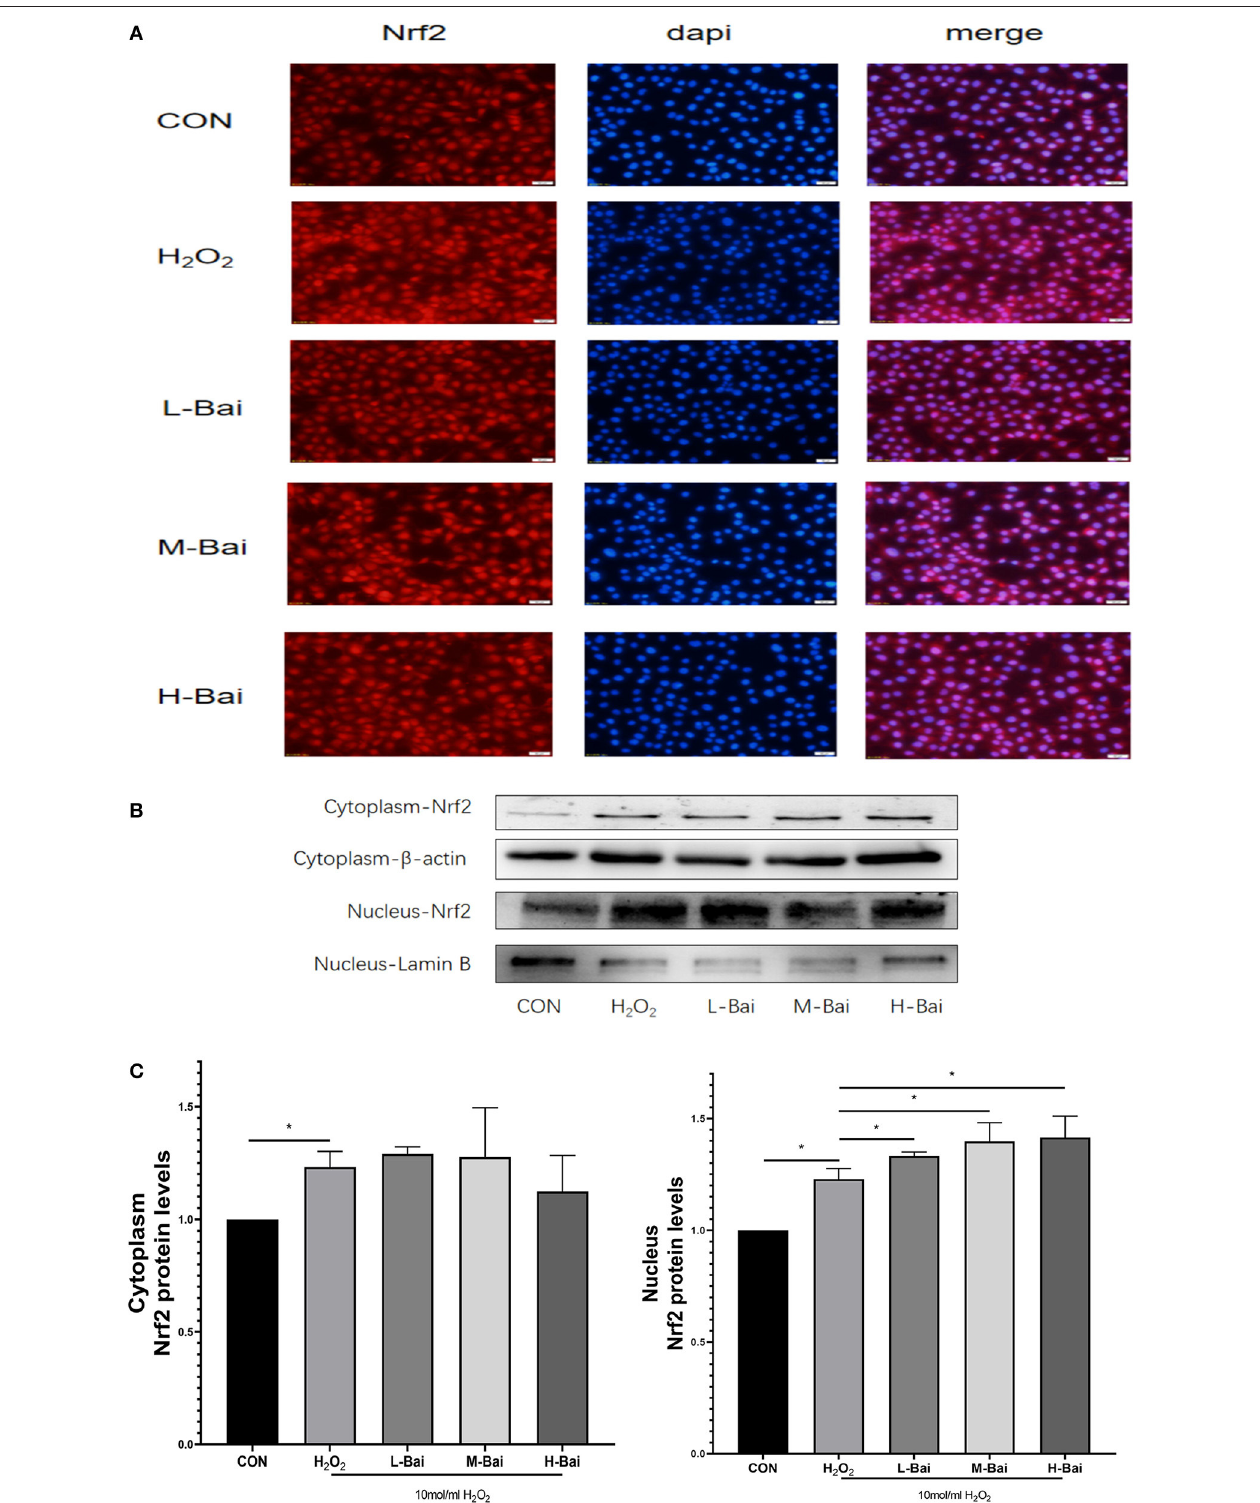
FIGURE 7 | Effects of baicalin on key proteins in the Nrf2 signaling pathway in H 2 O 2 -stimulated IPEC-J2 cells. Immunofluorescence detection of nuclear Nrf2 protein import in IPEC-J2 cells (A) . Western blotting was used to determine the expression of HO-1, Nrf2, β -actin, and lamin B (B) . Cytoplasmic and nuclear Nrf2 protein expression (C) . Data are presented as the mean ± SEM ( n = 3 per treatment, * p < 0.05 compared with the model group). CON, control; L-Bai, low-concentration baicalin; M-Bai, middle-concentration baicalin; H-Bai, high-concentration baicalin.